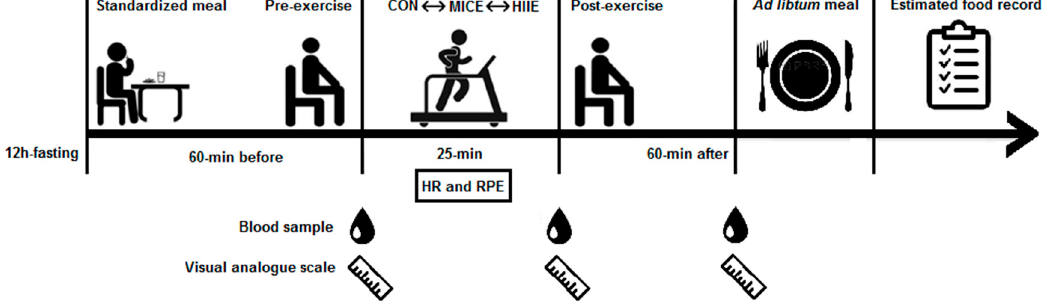
Figure 1. Flowchart of experimental sessions. Standardized meal after 12 h fasting; 60 min resting prior to exercise; exercise session; 60 min of recovery; Ad libitum meal; Estimated food record. HR: heart rate; RPE: Rate of perceived exertion.